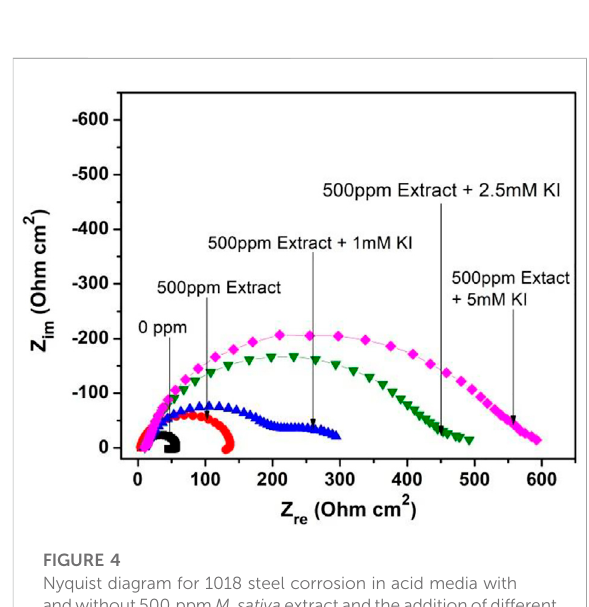
FIGURE 4 Nyquist diagram for 1018 steel corrosion in acid media with andwithout500 ppm M.sativa extractandtheadditionofdifferent KI concentrations at 40 ° C.